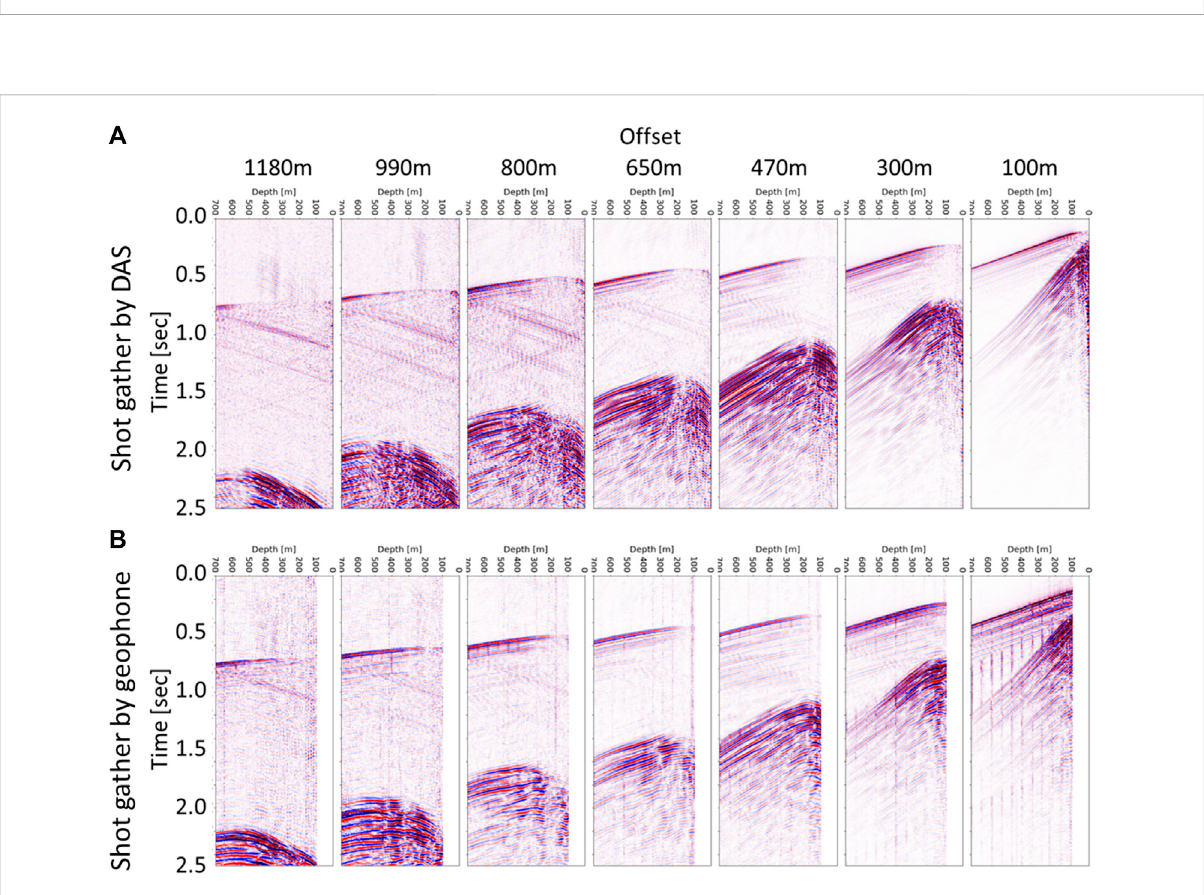
FIGURE 10 Shot gathers obtained by DAS (A) and geophone array (B) at each shot